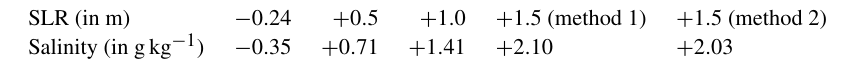
Table 9. Salinity changes averaged for the Baltic Sea in 1988–2007 relative to 1850 as a function of sea level rise (SLR). In the reference simulation, the mean salinity is 7.42gkg − 1 . In method 1, the increase in the water level was added to the first vertical grid box of the RCO-SCOBI model, while in method 2 the increase in the water level was evenly divided between the first and second grid boxes.